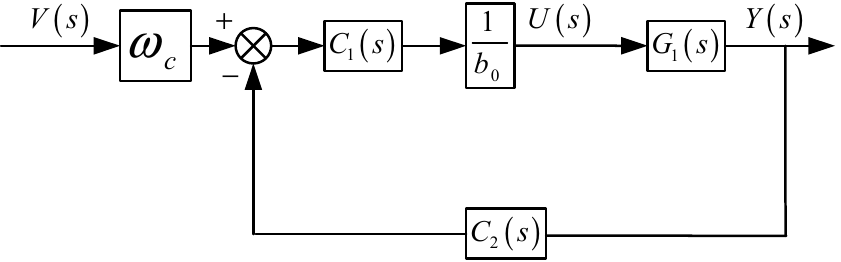
Figure 8. Simplified block diagram of the improved LADRC system.